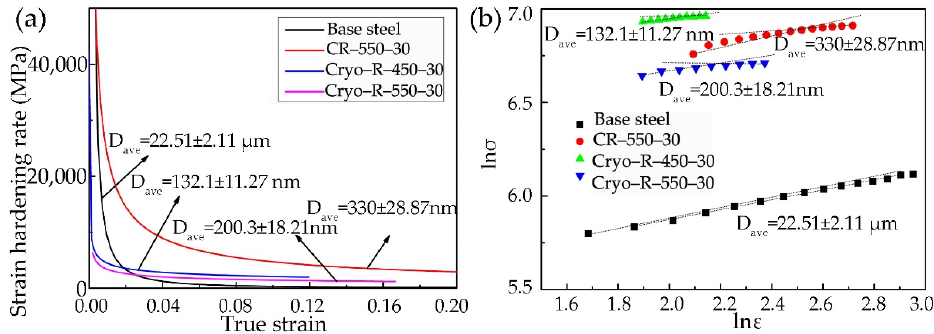
Figure 7. ( a ) Work hardening curves and ( b ) Hollomon analysis of the specimens.